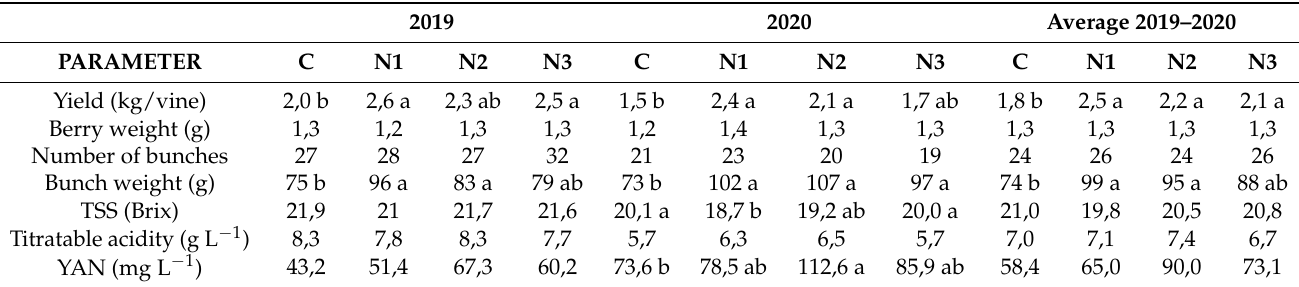
Table 3. Grapevine yield components and must quality parameters in the two years of study 2019 and 2020 for the four fertilization treatments. Data were processed using ANOVA; means followed by different letters differ significantly, as calculated using Tukey statistical analysis ( p ≤